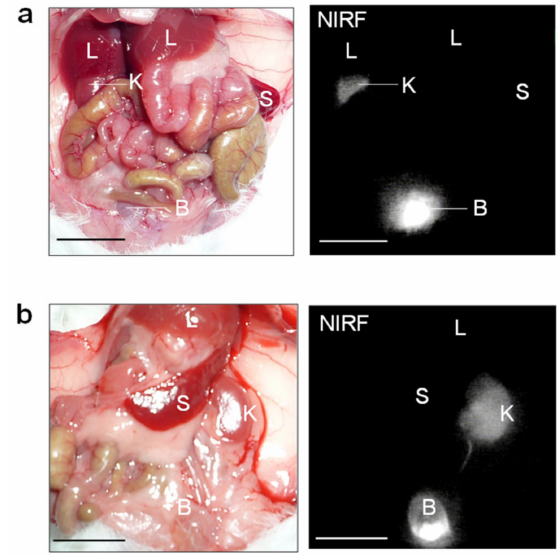
Figure 2. Representative in vivo near-infrared fluorescence (NIRF) imaging ( a , b ) of internal organs. Image was obtained at 10 min after the intravenous administration of ASP5354 (12 nmol/kg body weight) in healthy mice. NIRF is displayed in white. Scale bar = 10 mm. B, bladder; K, kidney; L, liver; S,